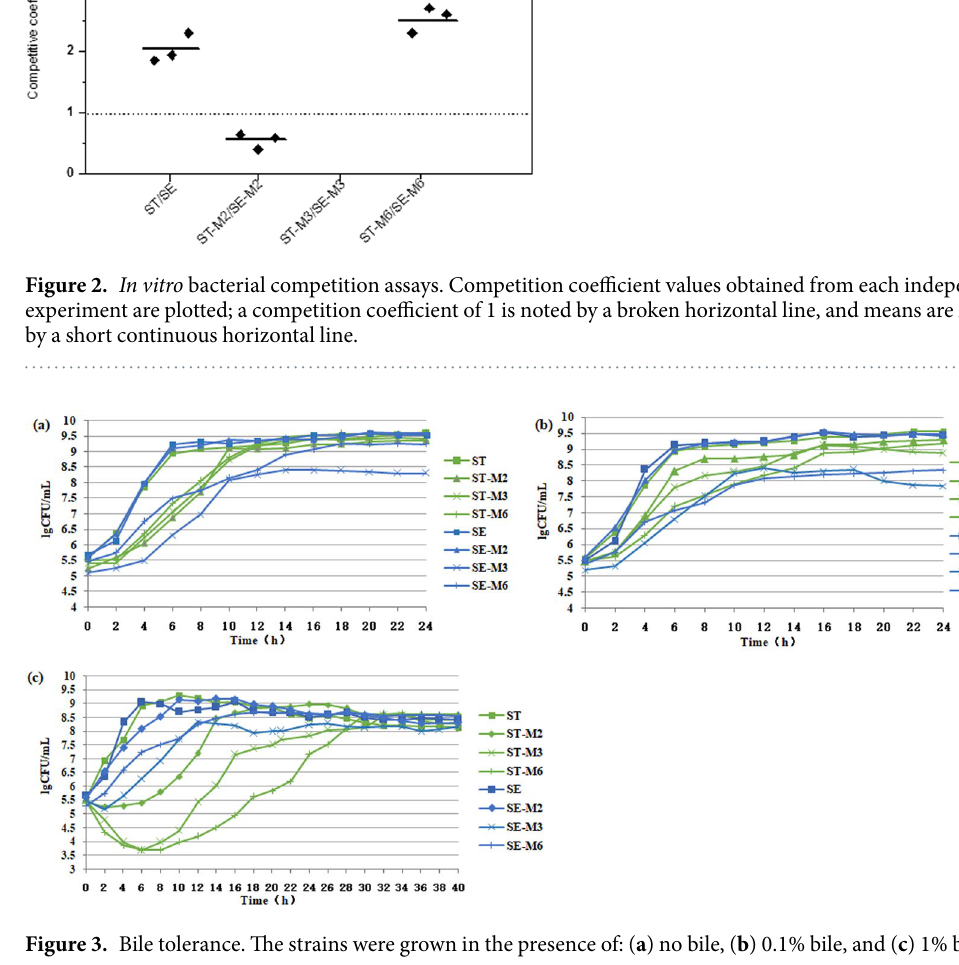
Figure 3. Bile tolerance. The strains were grown in the presence of: ( a ) no bile, ( b ) 0.1% bile, and ( c ) 1%